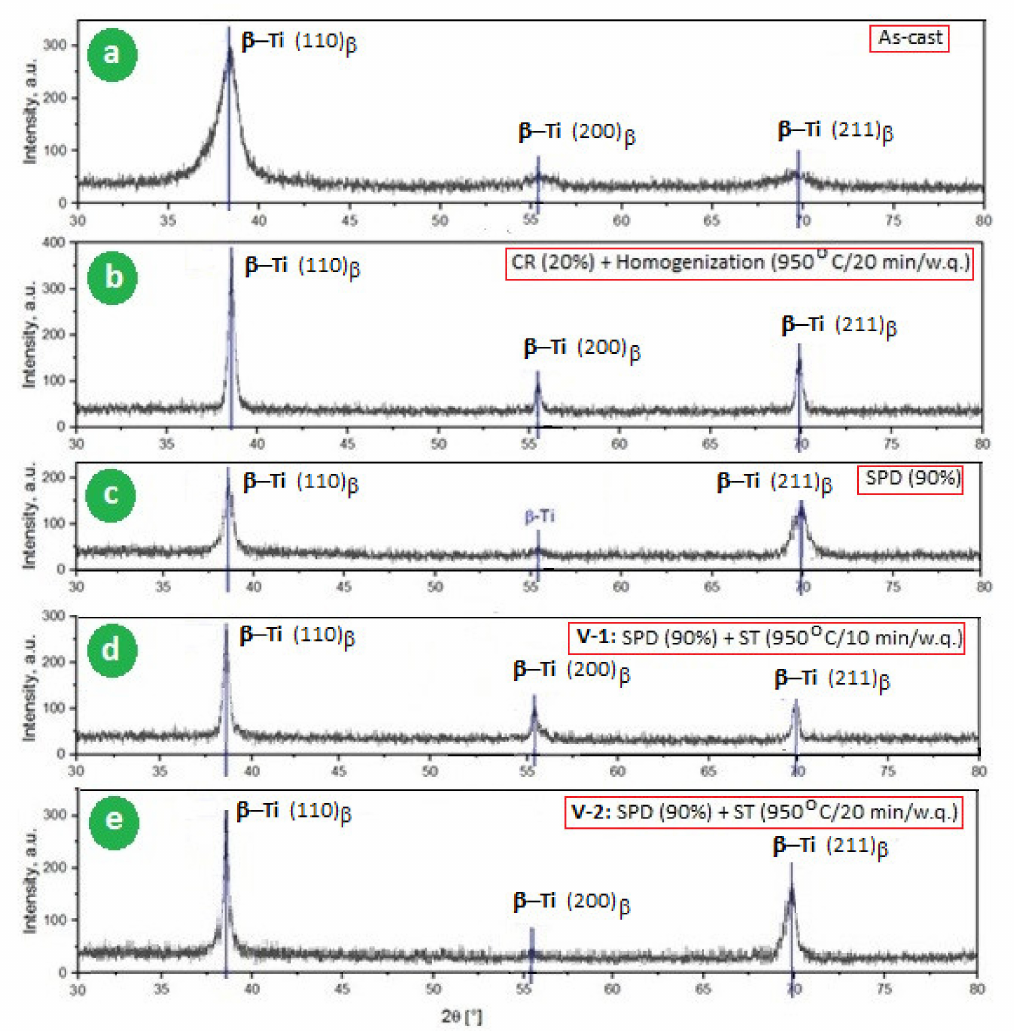
Figure 3. The XRD spectra of the studied alloy: ( a ) the as-cast sample; ( b ) after the homogenization treatment; ( c ) after the SPD (90%) processing; ( d ) V-1: SPD-MPR ( ε tot = 90%) + ST-1 (950 ◦ C-10 min-w.q.); and ( e ) V-2: SPD-MPR ( ε tot = 90%) + ST-2 (950 ◦ C-20 min-w.q.); ST-1: solution treatment-1; ST-2: solution